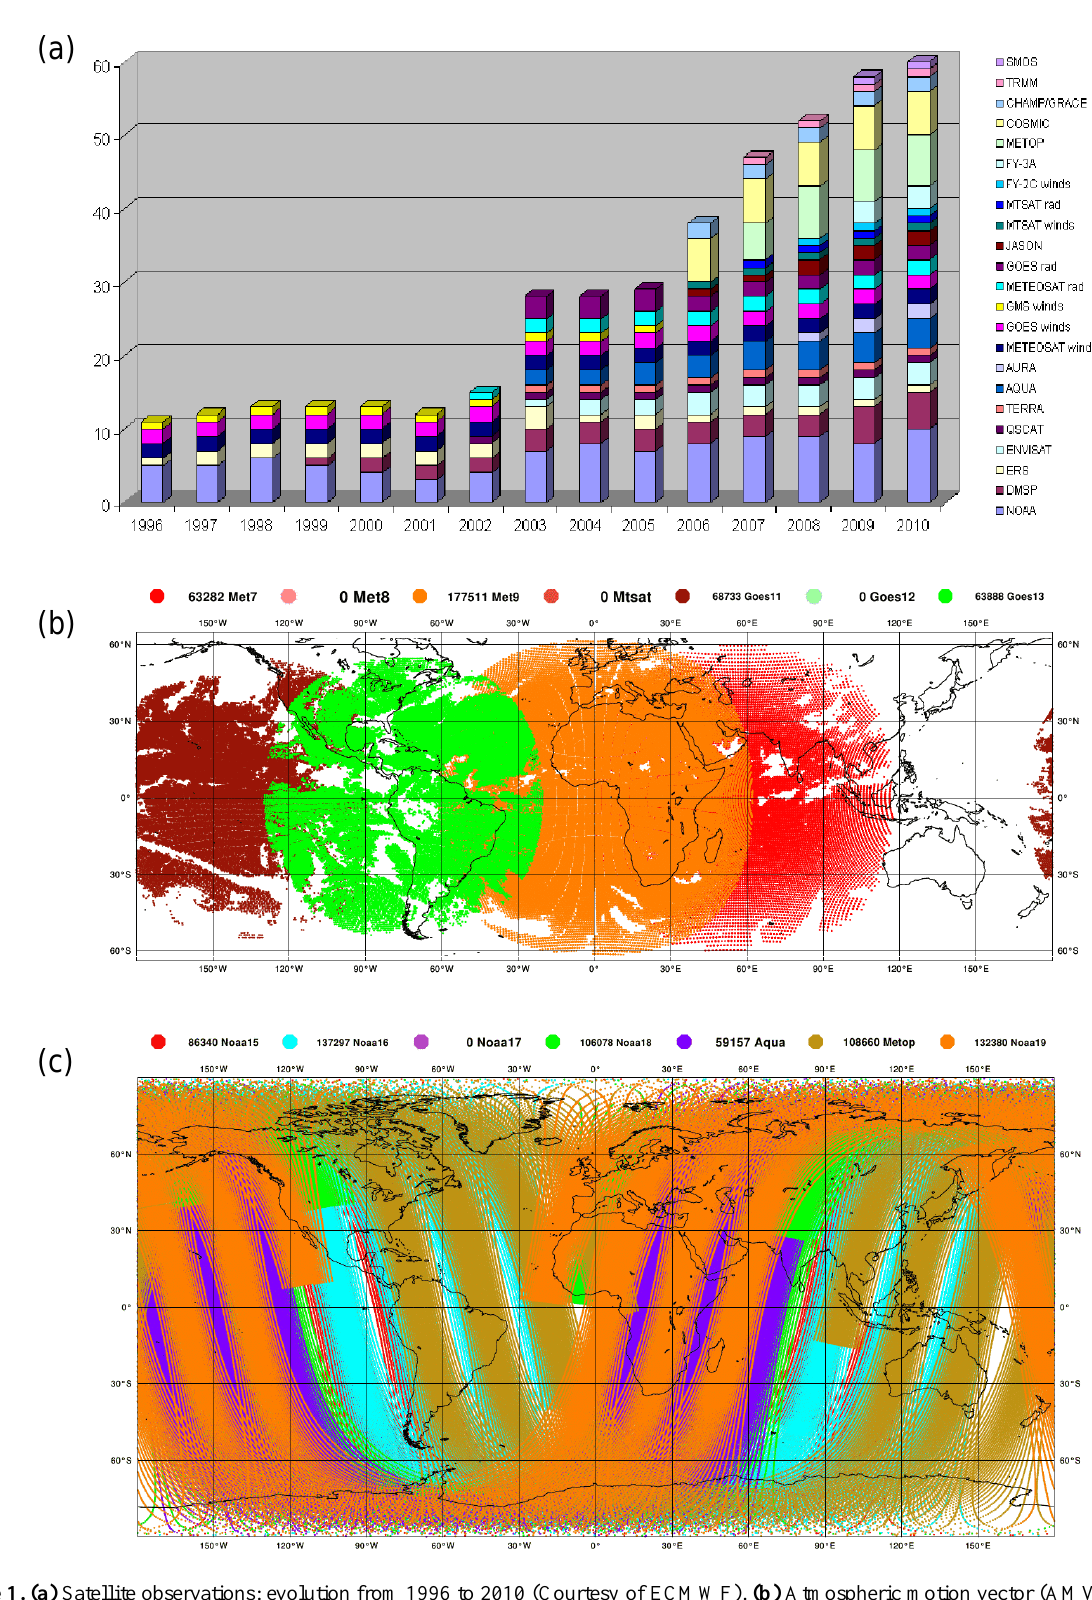
Figure 1. (a) Satellite observations: evolution from 1996 to 2010 (Courtesy of ECMWF). (b) Atmospheric motion vector (AMV) coverage by geostationary satellites. (c) Data coverage by polar orbiting satellites equipped with AMSU-A